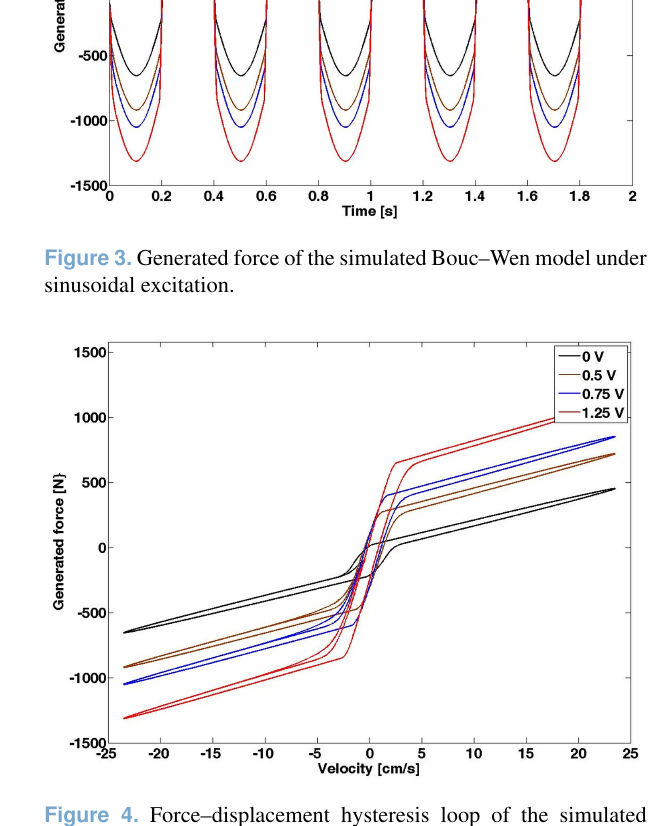
Figure 4. Force–displacement hysteresis loop of the simulated Bouc–Wen model under sinusoidal